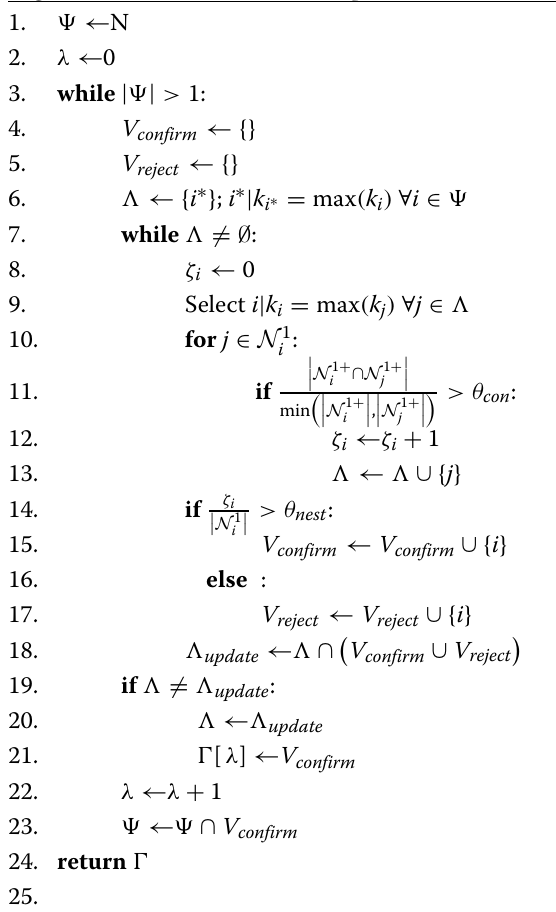
Algorithm NESTLON (multi-component